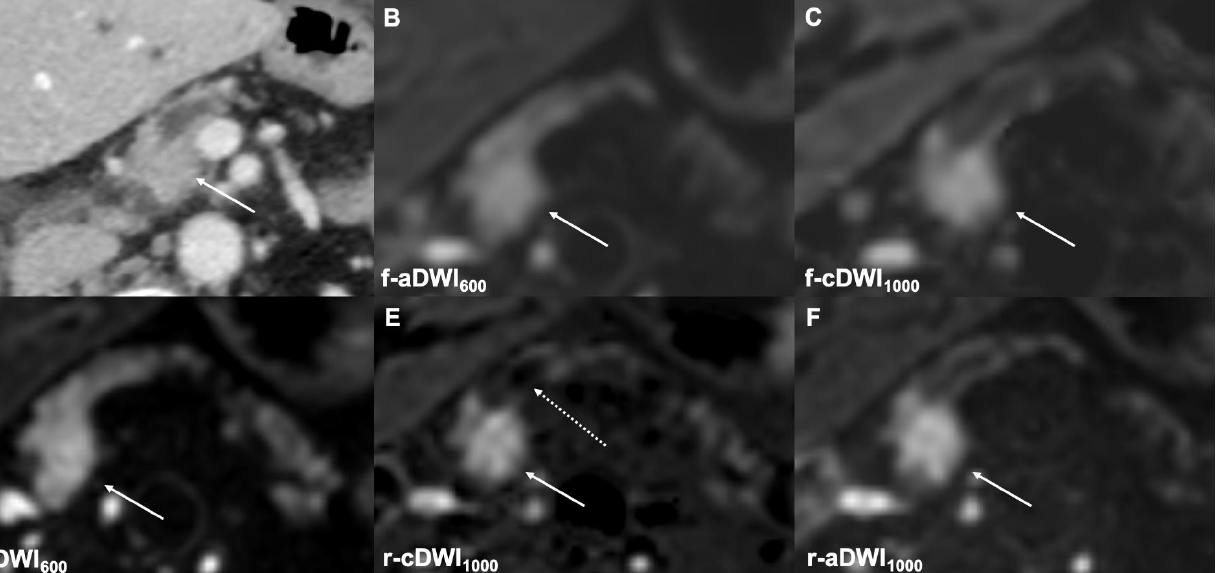
Figure 3. The axial T2w image ( A ) depicts a small pancreatic tumor in the uncinate process. The tumor is only poorly detected in the f-aDWI600 ( B ), f-cDWI1000 ( C ), and r-aDWI600 ( D ) images. The r-cDWI1000 ( E ) image yields superior tumor delineation in comparison to directly acquired images at b = 1000 s/mm 2 r-aDWI1000 ( F ). The labeling in image ( E ) has been corrected.